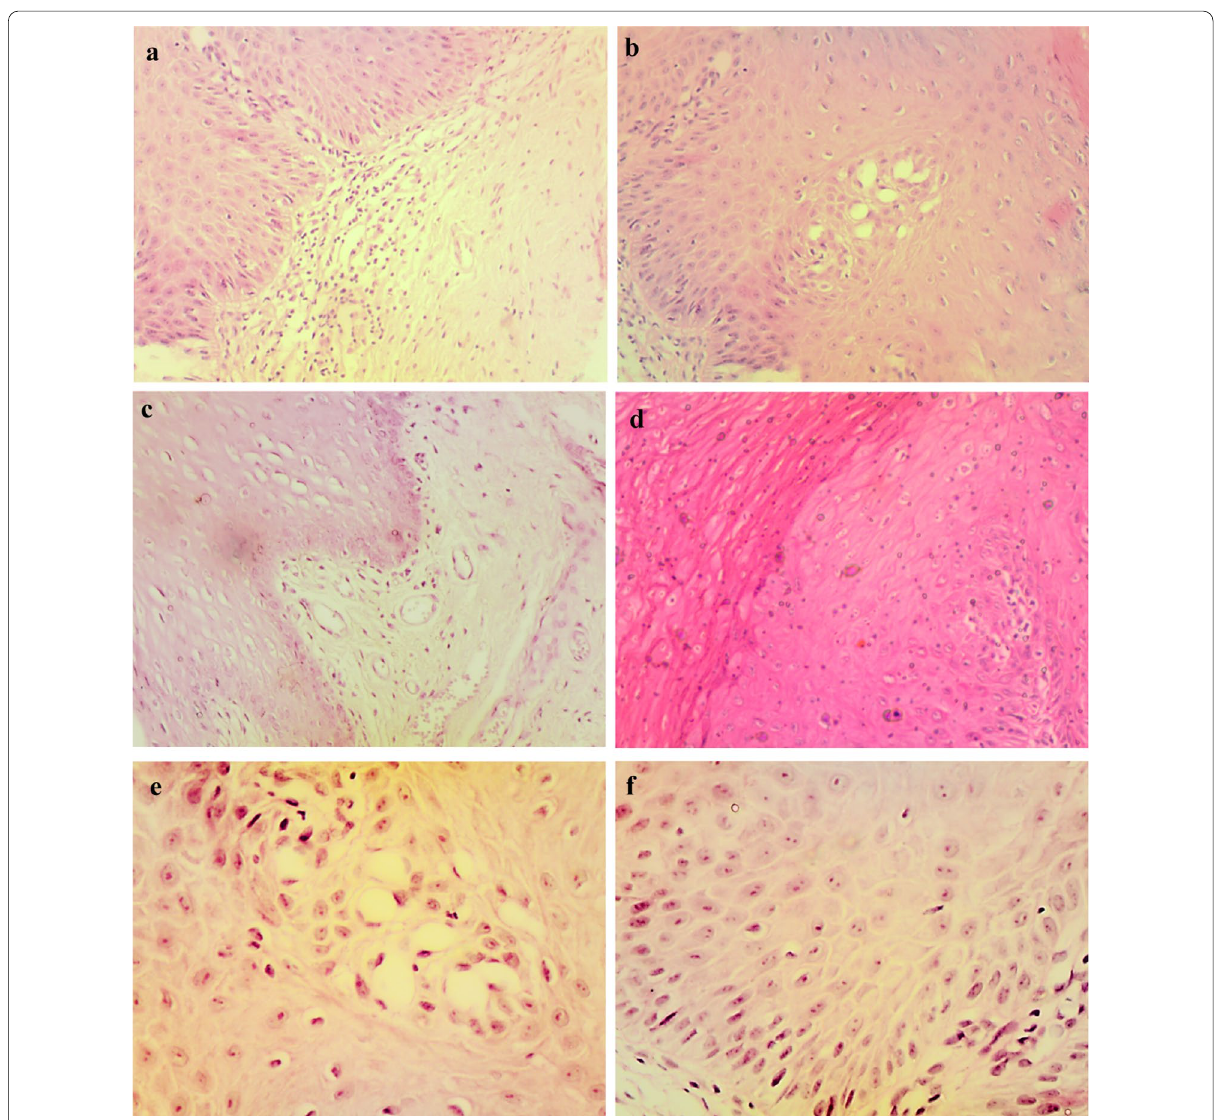
Fig. 1 Photomicrograph showing different dysplastic features a basal cells showing hyperplasia, loss of polarity, subepithelial inflammatory cell infiltration, b loss of cohesiveness between cells, c intact basement membrane with loss of cohesiveness, subepithelial inflammatory cell infiltrate, d hyperkeratosis (H&E stain, 100 µm), e abnormal mitotic figures, f nuclear hyperchromatism and abnormal mitosis (H&E stain, 200